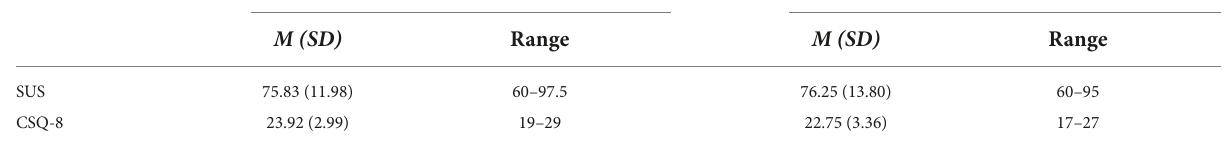
TABLE 5 Patient feasibility outcomes for mEMA at T 1 and T 2